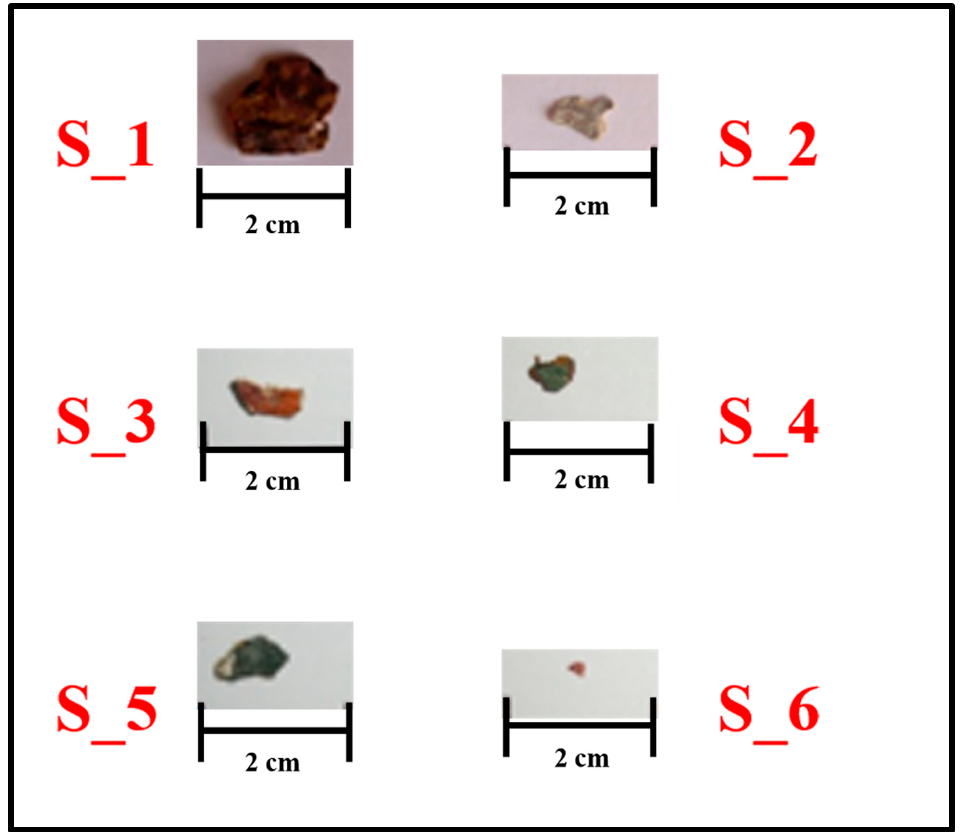
Figure 2. Photographs of the six specimens of the Crucifix which were analyzed. tion on the pigments used. For instance, both samples S_4 and S_5, from the thong, appear green; however, the pigments found are not green, but yellow and